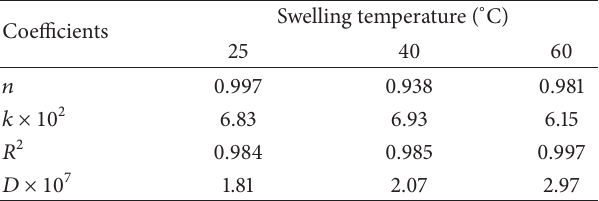
Figure 6: Hydrogel swelling content values for both experimental and predicted values based upon to the exponential association model. Table 1: Values of swelling coefficients of dried